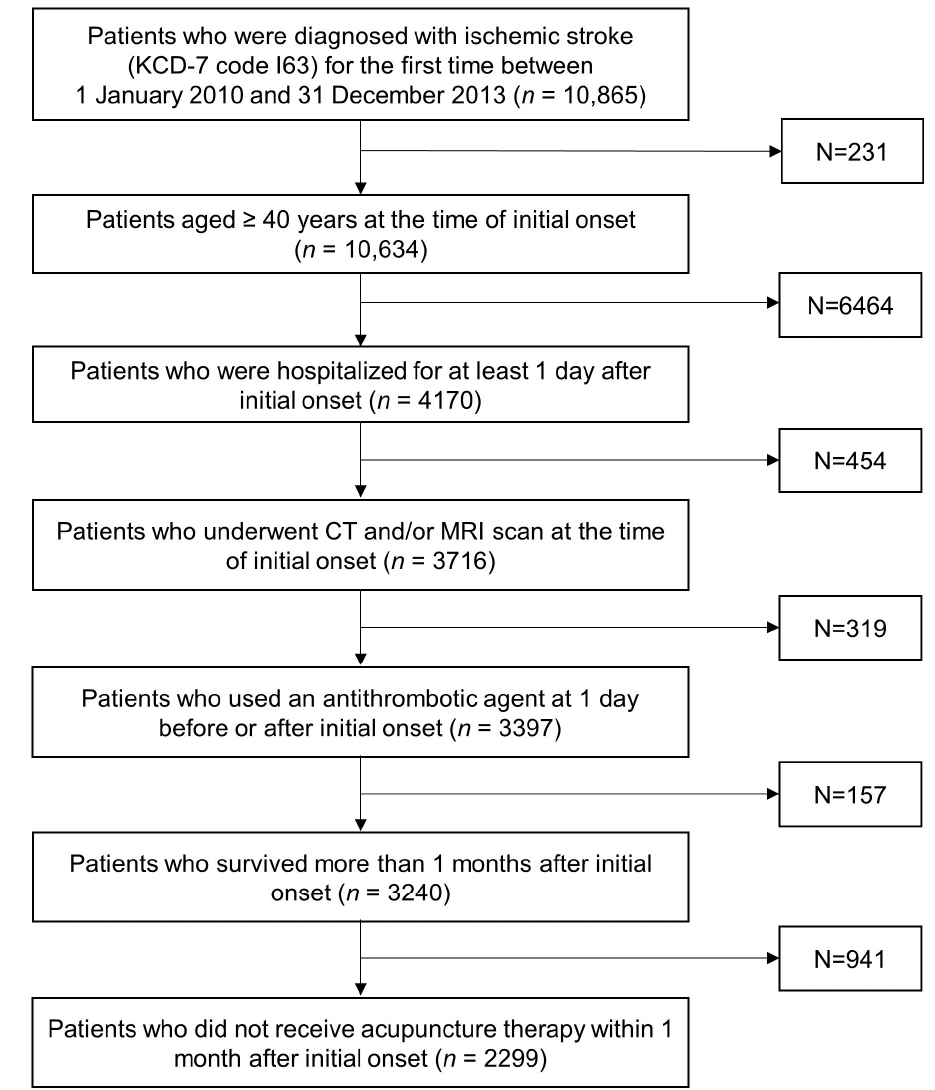
Figure 1. Flowchart of the study population. KCD: Korean Classification of Diseases; CT: computed tomography; MRI: magnetic resonance imaging.